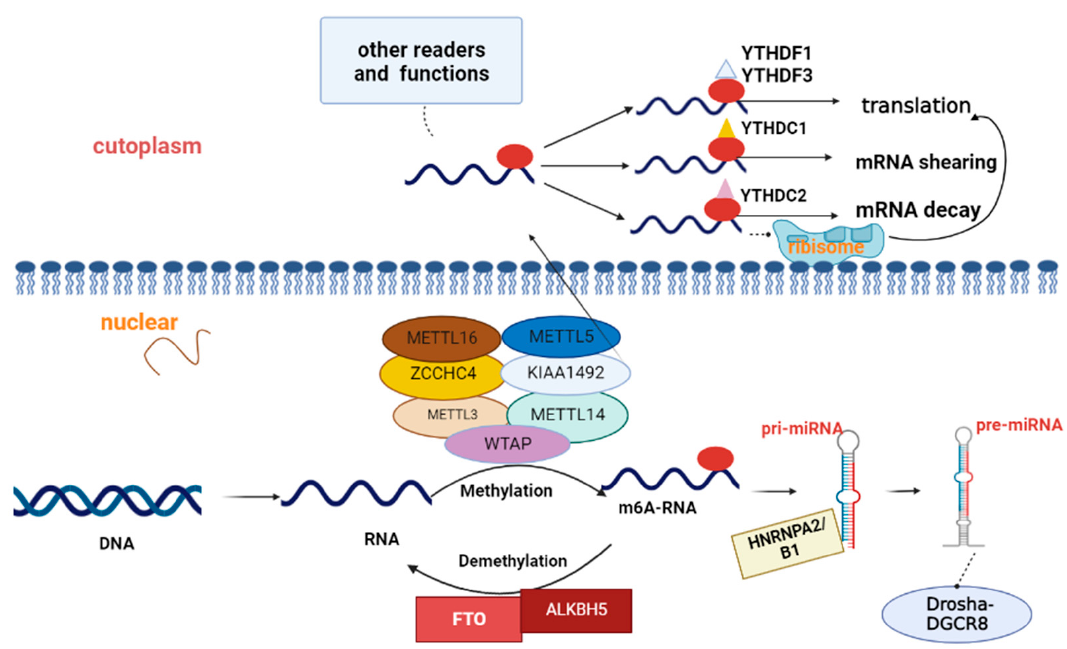
Figure 3. Mechanism of action of m 6 A. The m 6 A methylation by methyltransferase catalytic mod- ification is mainly through the formation of a complex through METTL3, METTL14, and WTAP, and is independently catalyzed by KIAA1429 cofactors, METTL5, METTL16, and ZCCHC4. The m 6 A modification is removed by the demethylases FTO or ALKBH5. Nuclei m 6 A readers promote miRNA processing and export. Cytoplasmic readers are involved in RNA translation, splicing, and degradation processes.